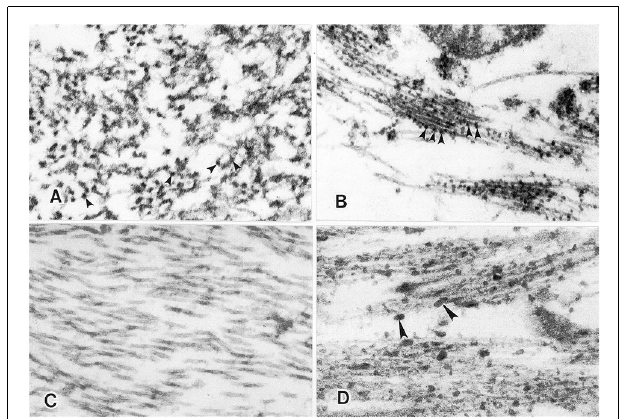
FIGURE 5 | Proteoglycans visualized in neuritic plaques and neurofibrillary tangles as demonstrated by Ruthenium red and Cuprolinic blue staining. (A) Ruthenium red staining of neuritic plaque in the hippocampus of a 92-year old female with AD. Positive Ruthenium red granules (arrowheads) are specifically localized along amyloid fibrils present with the neuritic plaque. (B) Ruthenium red staining of paired helical and straight filaments in a neurofibrillary tangle in the hippocampus of a 72-year old male with AD. Positive Ruthenium red granules are observed (arrowheads) specifically localized to the paired helical and straight filaments. Orig. Mag., × 80,000. (C) In the absence of Cuprolinic blue, no apparent staining of paired helical and straight filaments in a neurofibrillary tangle is observed in the hippocampus of a 92-year old female with AD. Original mag. × 80,000. (D) In the presence of Cuprolinic blue at 0.3 M magnesium chloride, proteoglycans are visualized as positive Cuprolinic blue filaments (arrowheads) in intimate association with bundles of